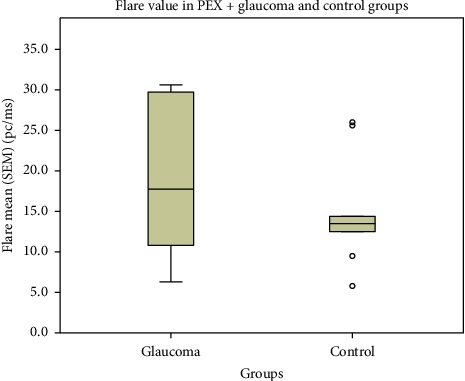
Flare value among (PEX−) control and glaucoma groups. The mean values did not differ significantly; however, the glaucoma (PEX−) group showed a higher aqueous humour flare tendency than the control group.